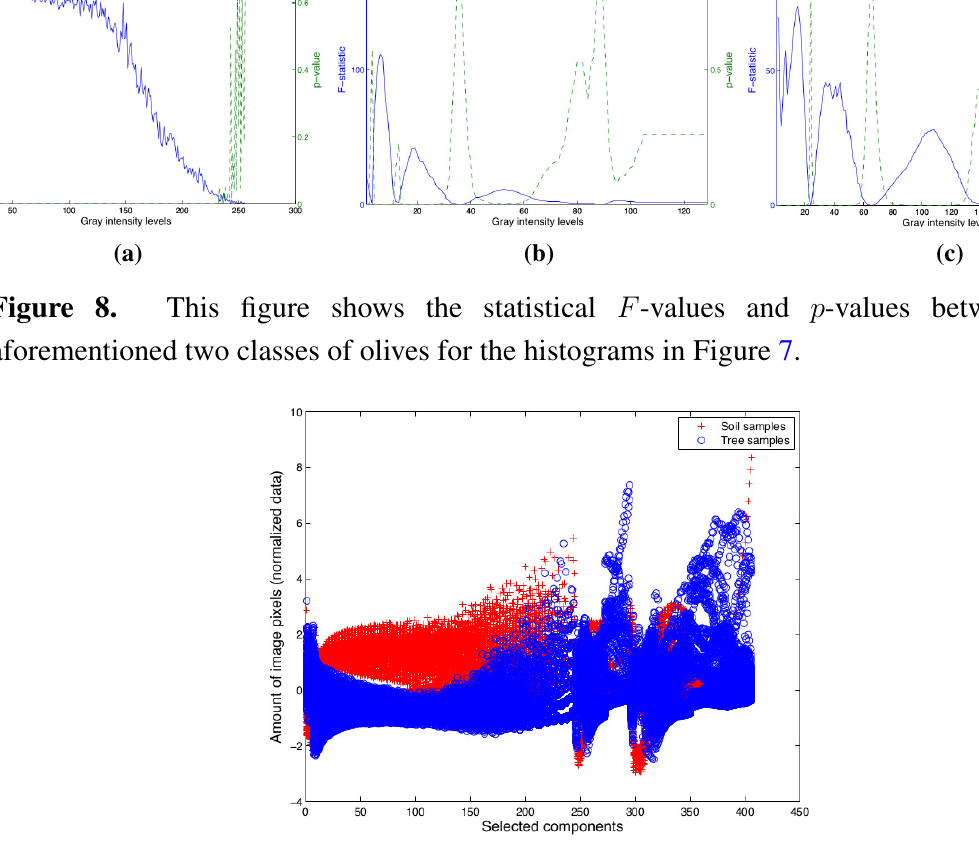
Figure 9. Feature vectors of the whole dataset after filtering by the ANOVA test.